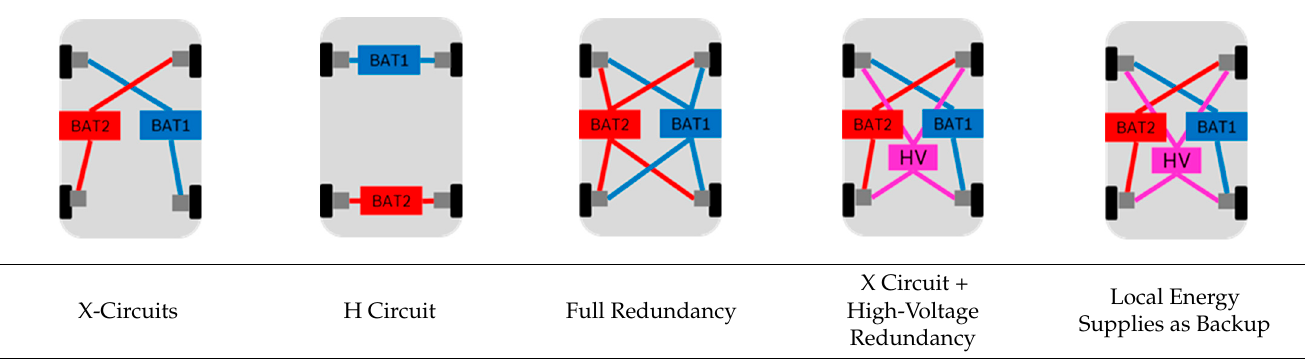
Table 8. Overview of Control Topologies.